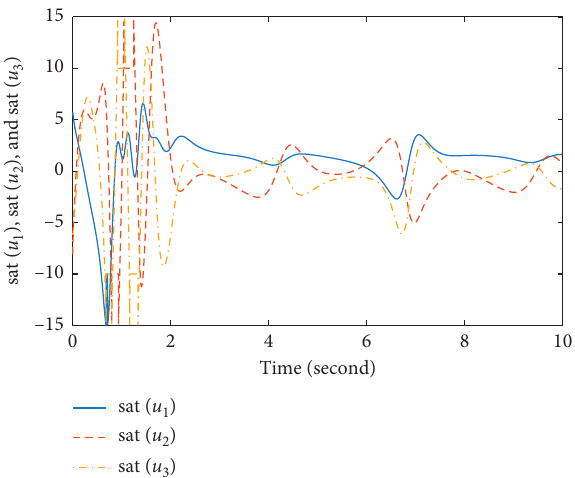
Figure 4: Trajectories of sat ( u